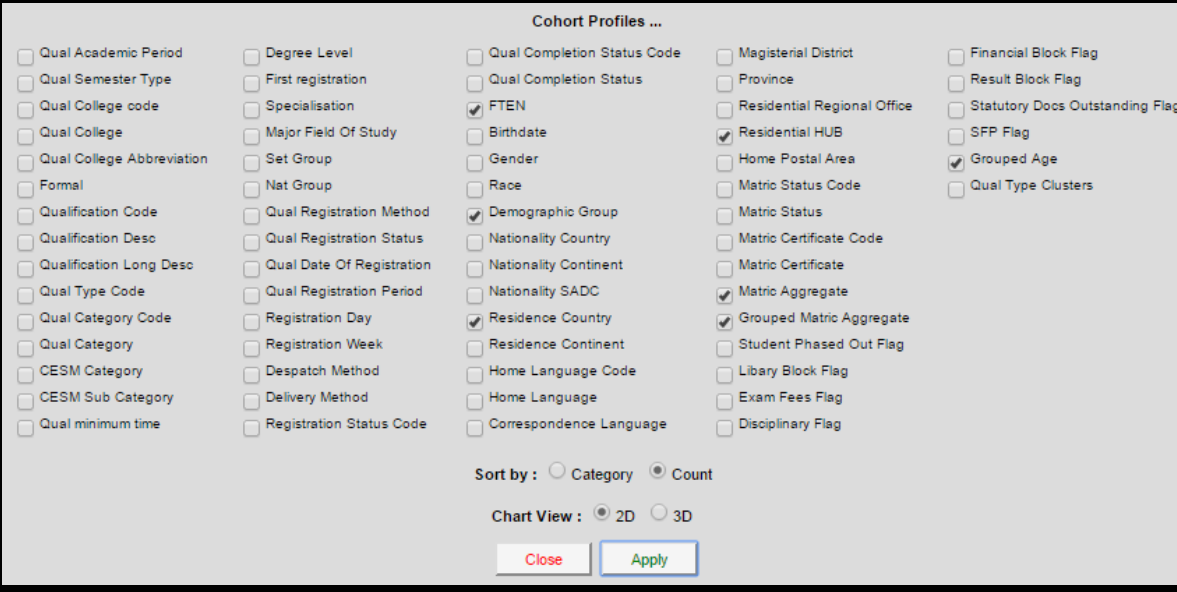
Figure 10. Excerpt cohort view – profile display